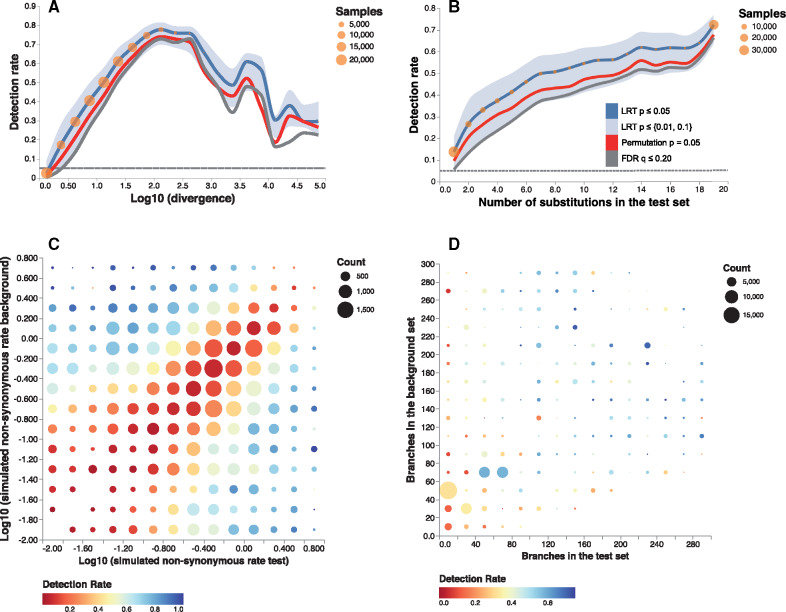
Contrast-FEL performance data with rate differences (power). The plots are based on 139,753 variable sites simulated with unequal nonsynonymous rates on two branch sets (see text for simulation details). (A) Detection rate as a function of the  log 10 of the divergence level at the site. Blue line: proportion of sites with LRT P < 0.05, red line: proportion of sites with permutation P < 0.05, gray line: proportion of sites with q < 0.20. Blue area plot shows for the proportion of sites with LRT P < 0.01 (lower) and LRT P < 0.1 (upper). Orange circles reflect the number of sites contributing to each bin. (B) Detection rate as a function of the number of inferred substitutions in the test set; same notation as in (A) otherwise. (C) Detection rate as a function of the simulated nonsynonymous rates in test and background branch sets and (D) the numbers of branches in the test and reference set.